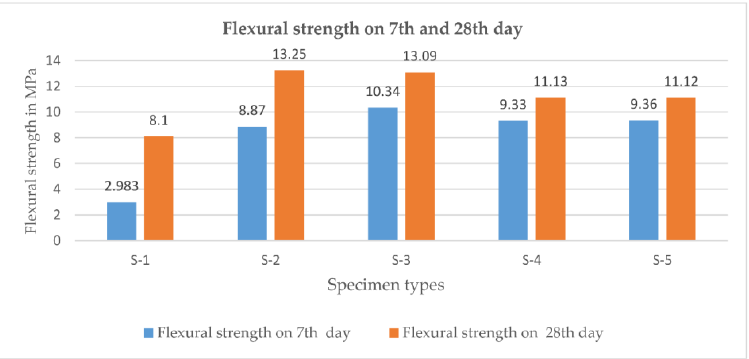
Figure 6. Flexural strength of concrete samples after 7 and 28 days of hardening.